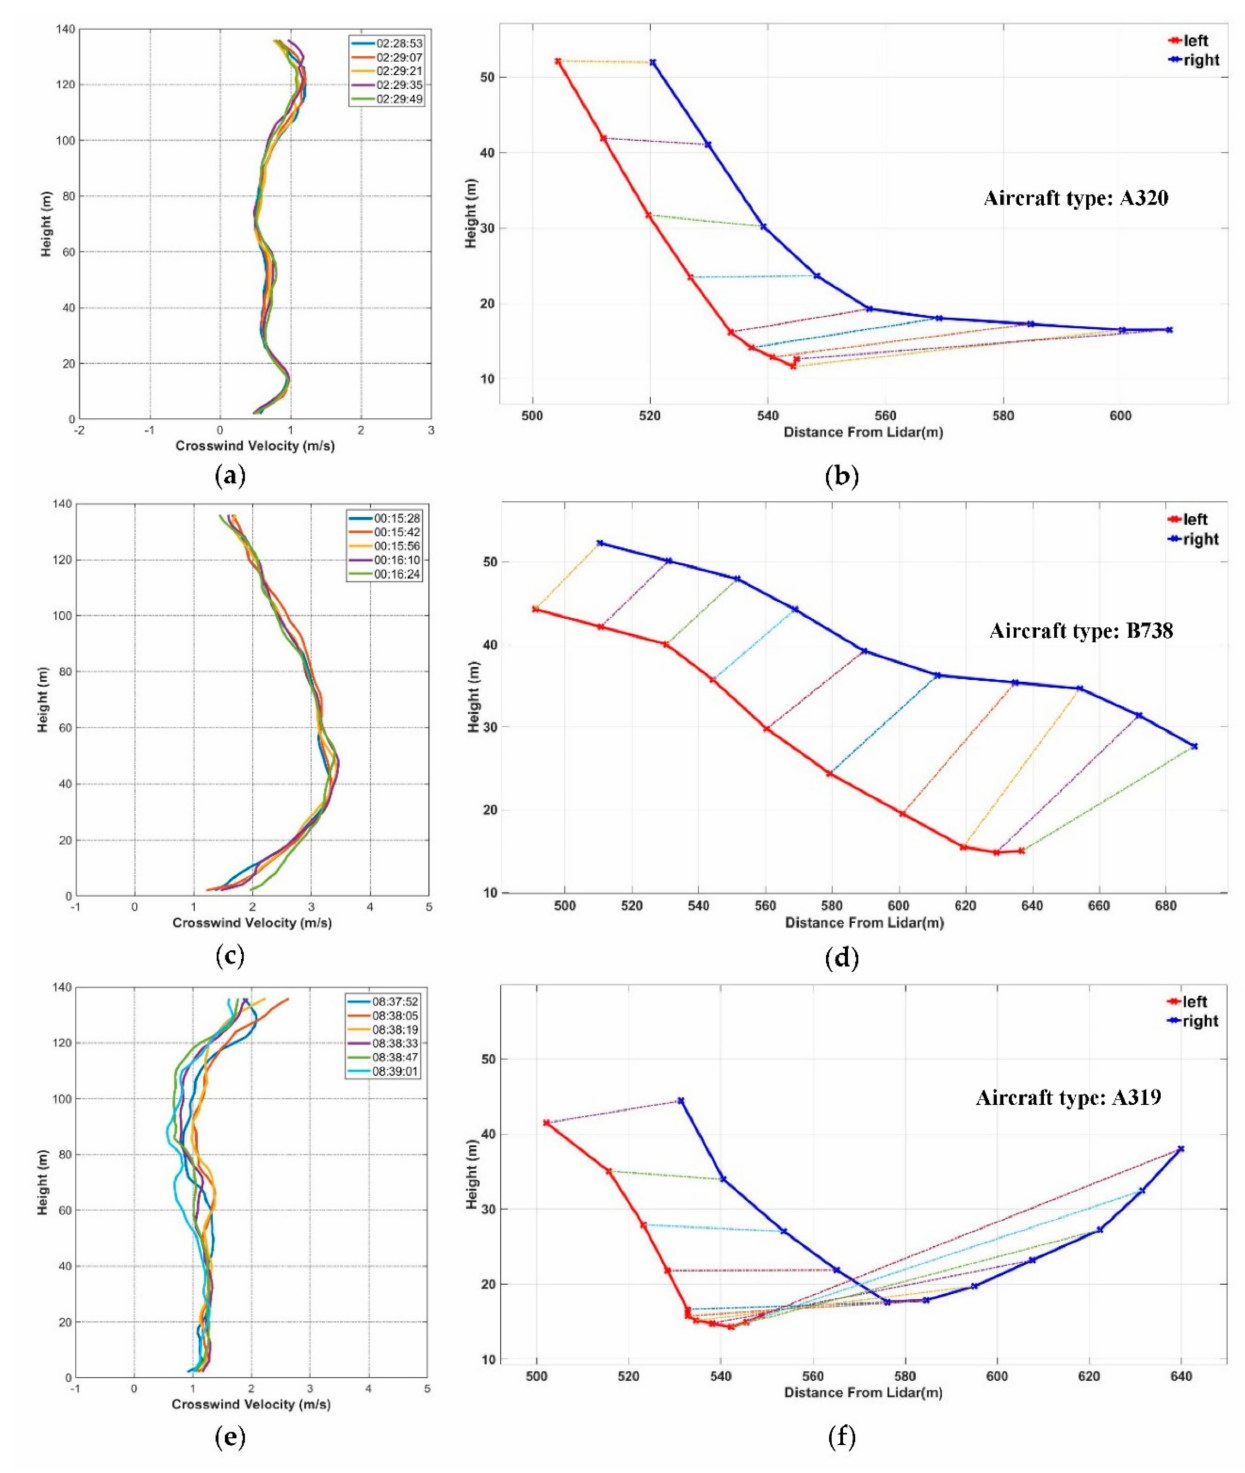
Figure 11. Wake vortex trajectories under various crosswind conditions. ( a ) The crosswind profiles and ( b ) wake